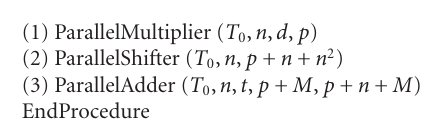
Algorithm 4: Procedure Traceback ( T 0 , t , d , p , n